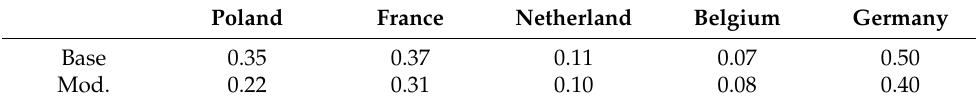
Table 5. The monthly mean value of emission NOx (10 3 kt) before and after